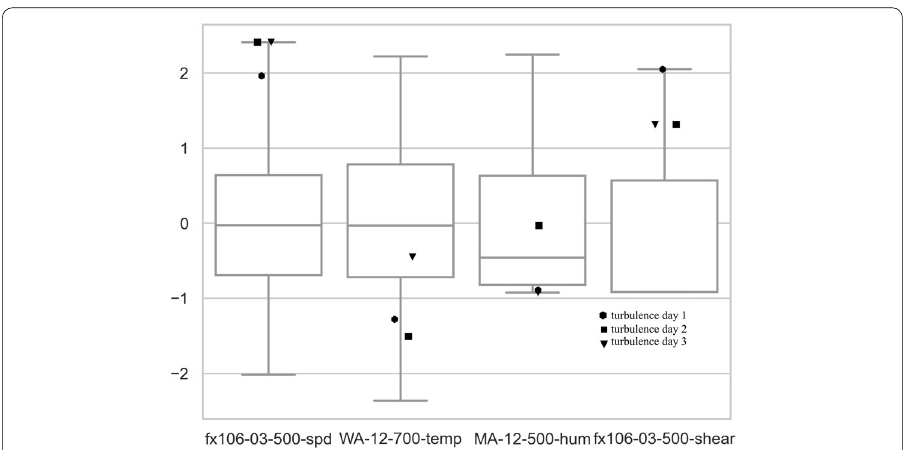
Fig. 4 Dataset comparison by wind speed, temperature, humidity, and shear